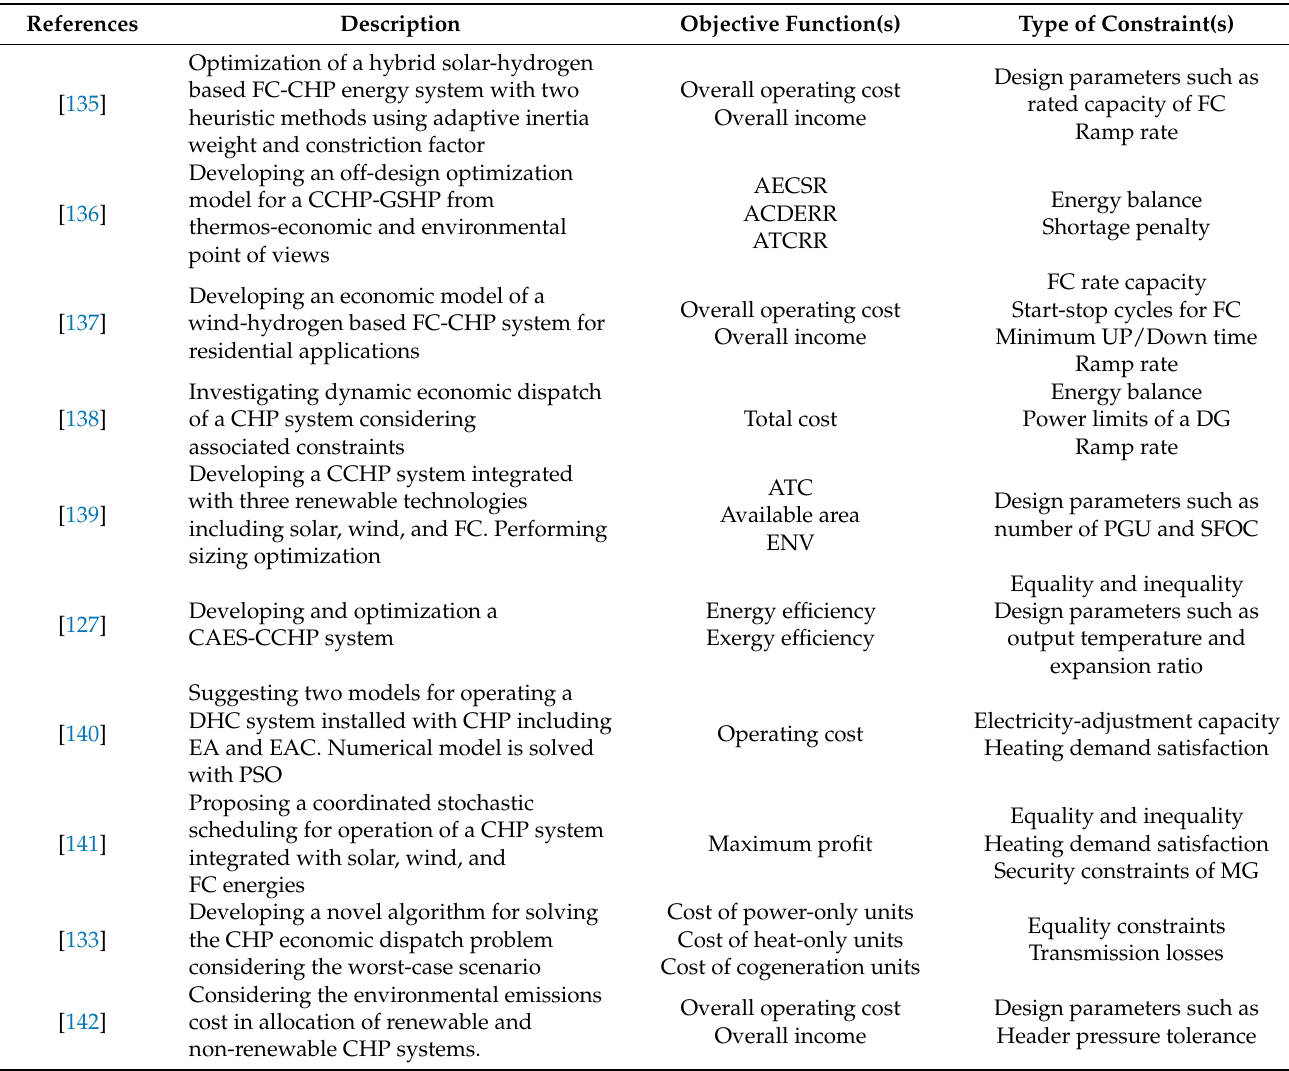
Table 2. Selected preliminary studies on energy system optimization using the Particle Swarm Optimization (PSO)